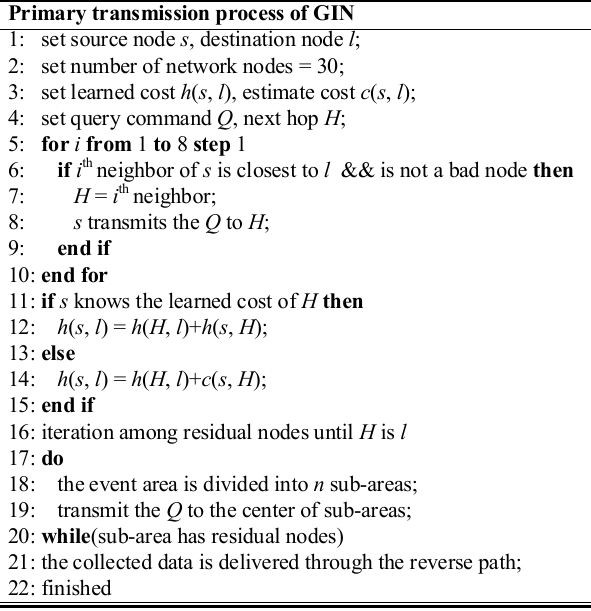
Figure 8. The transmission process in